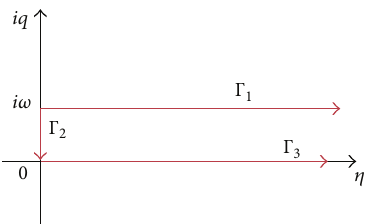
Figure 2: The complex plane of the wave number 𝜂 , integration pathes shown. Γ 1 is the original path in (74). It is equivalent to Γ 1 (region (a)) and Γ 2 (region (b)) in (76).